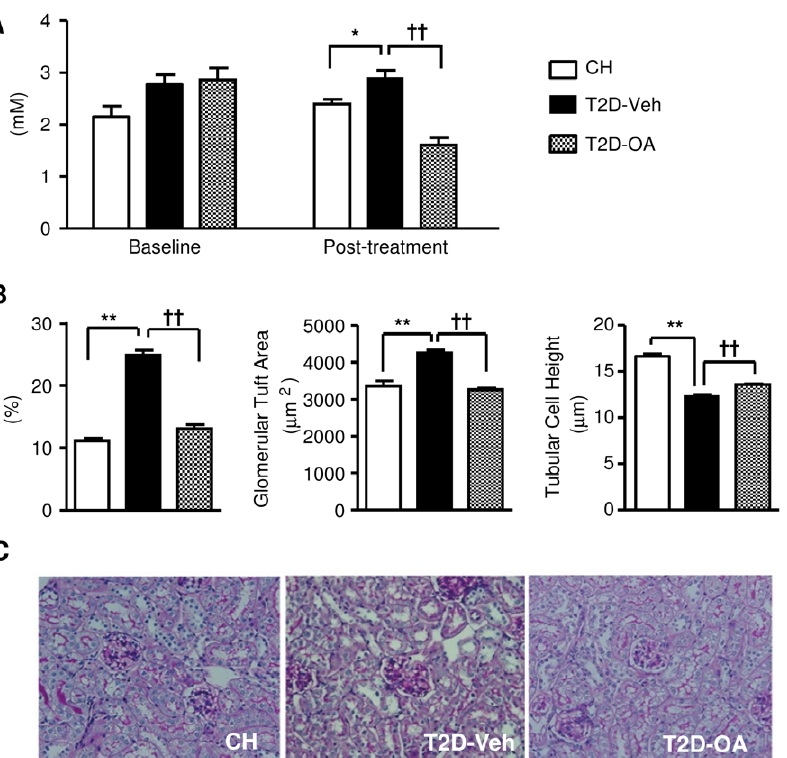
Figure 4. Effects of OA on glucose levels in urine and kidney morphology. Urine glucose levels in CH, T2D-Veh and T2D-OA mice were measured before the OA treatment began and at the end of the study (4 weeks after cessation of OA treatment) ( A ). Kidneys were harvested and coronal sections of renal tissues were stained with periodic acid-Schiff for the quantification of interstitial volume, glomerular tuft area and tubular cell height ( B ). Representative images of stained kidney sections ( C ). T2D-Veh, HF-fed mice with STZ injections; T2D-OA, HF-fed mice with STZ injections and OA treatment. * p , 0.05, ** p , 0.01 vs. CH; {{ p , 0.01 vs. T2D-Veh, n=5–10 per group.